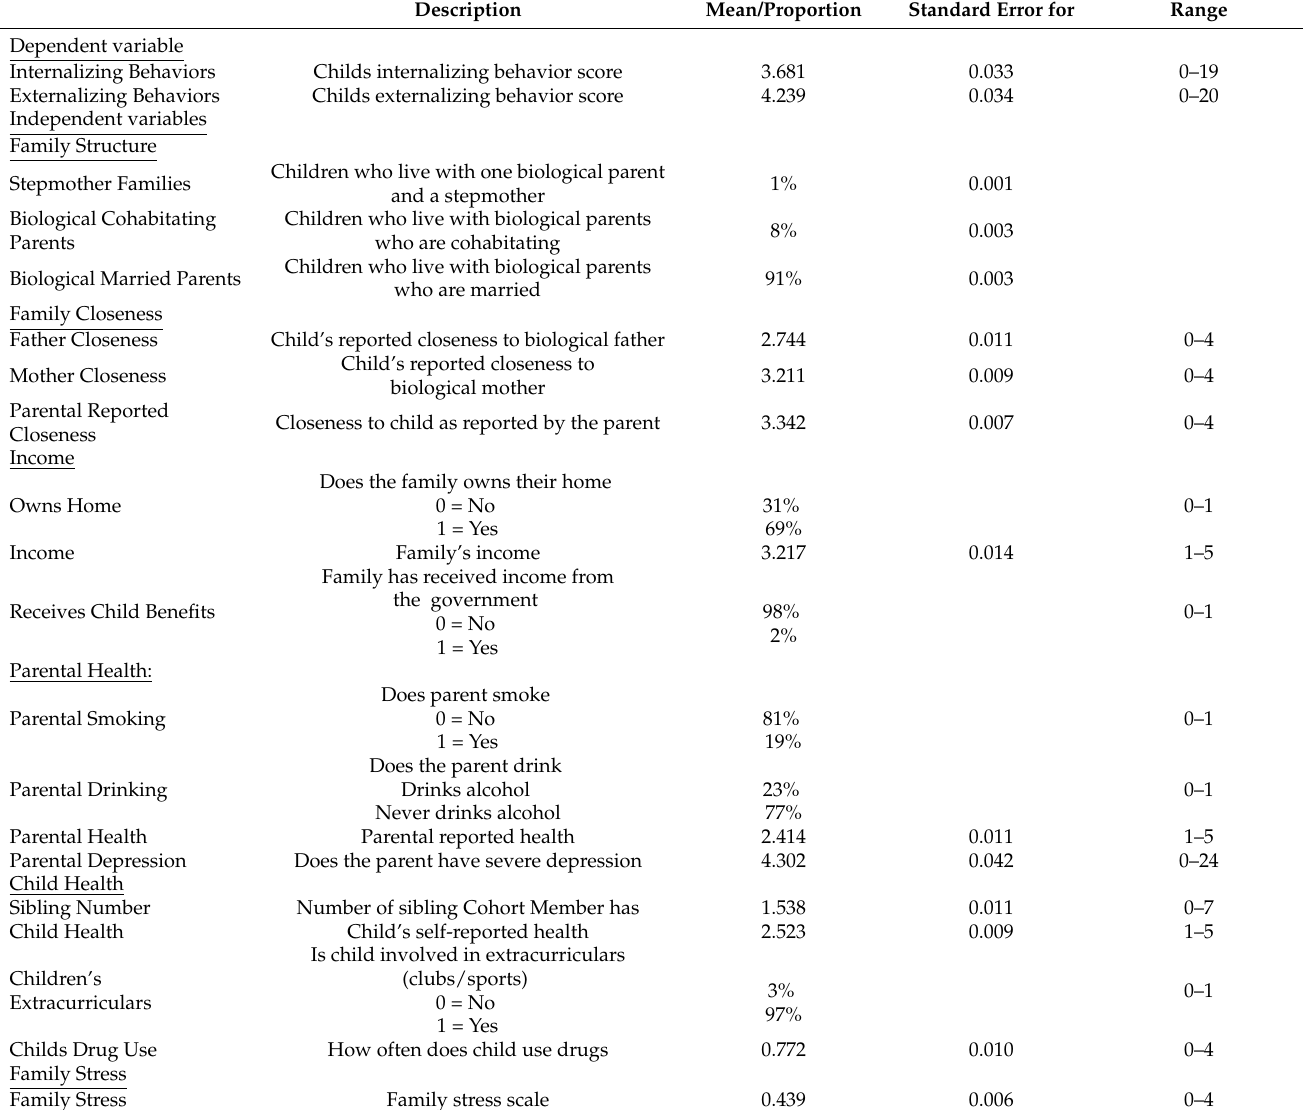
Table 1. Measurement and Descriptive